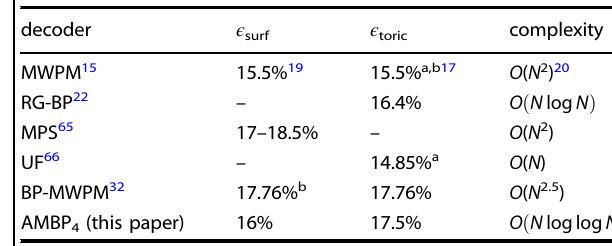
provided in the